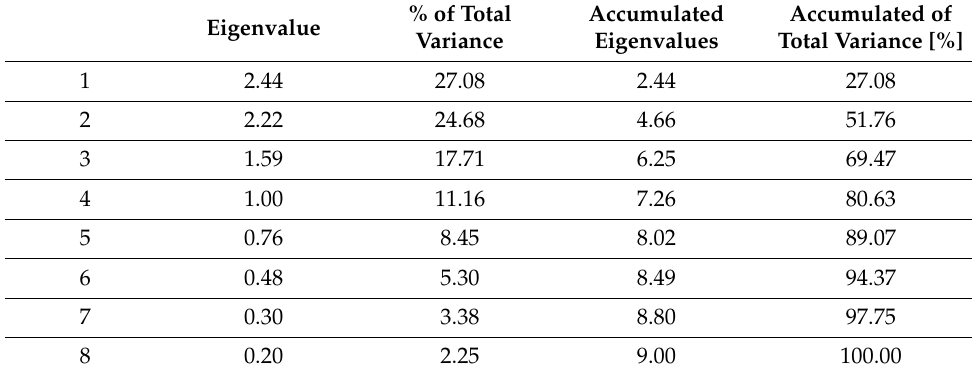
Table 4. The results of PCA conducted for an additional variable–thermal factor.